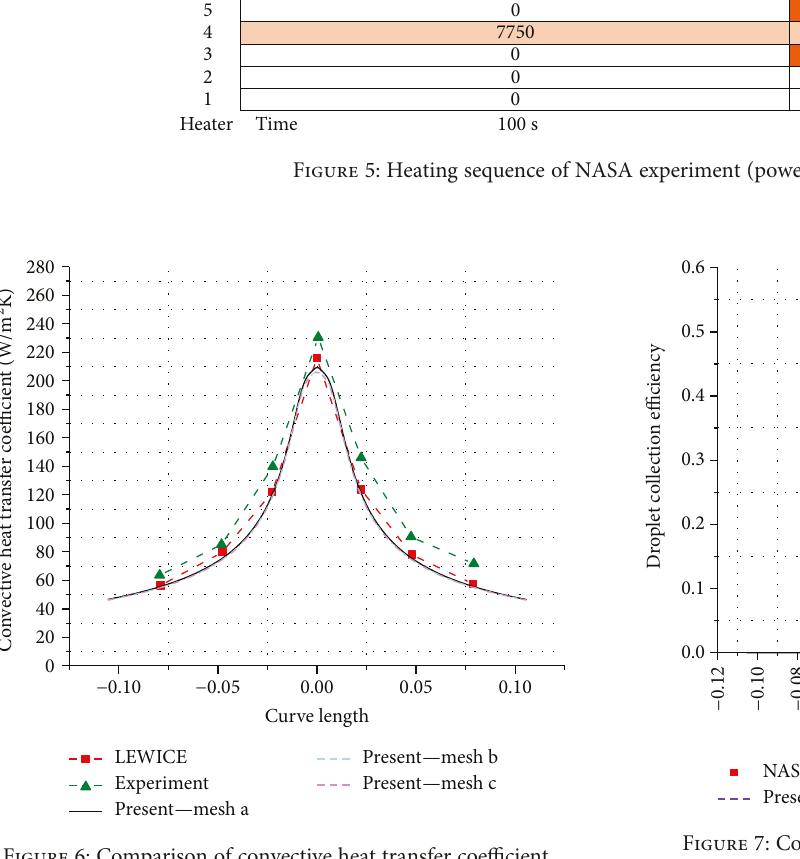
Figure 6: Comparison of convective heat transfer coe ffi cient.